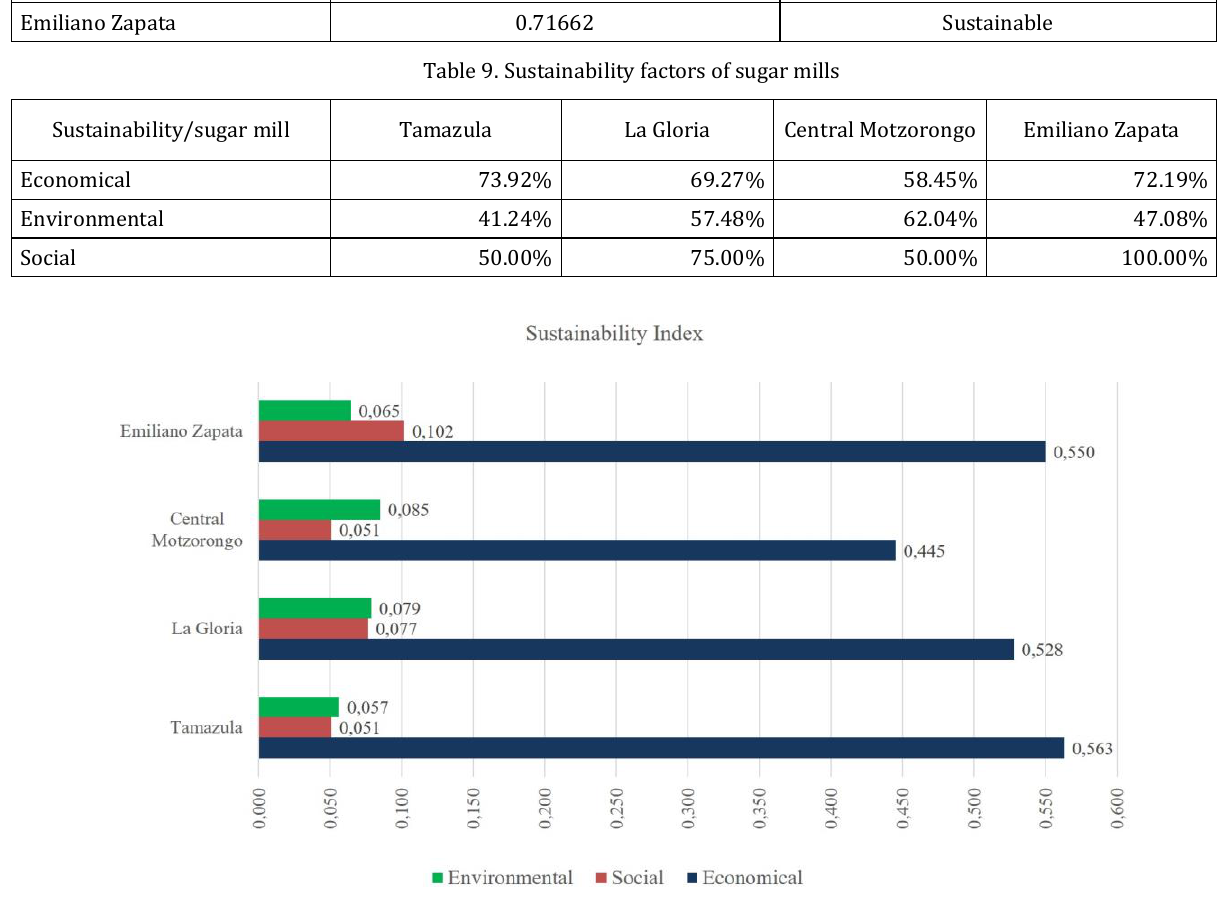
Fig. 9. Sustainability values of sugar